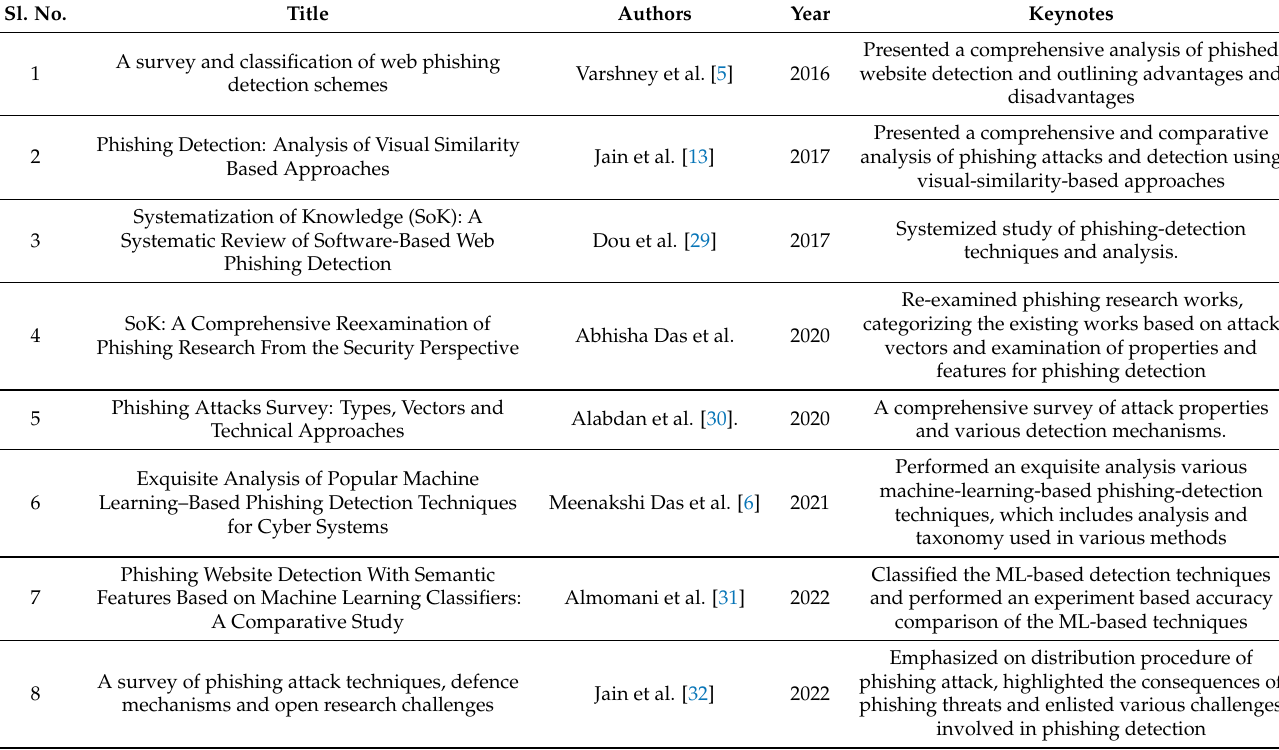
Figure 4. Fraudulent vs. genuine google